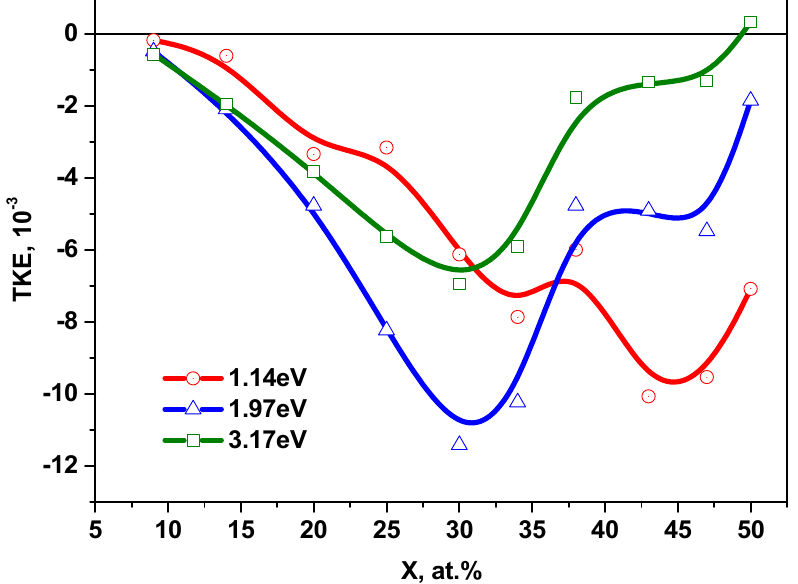
Figure 7. Concentration dependences of TKE of nanocomposites on the glass substrates at the different energy values.